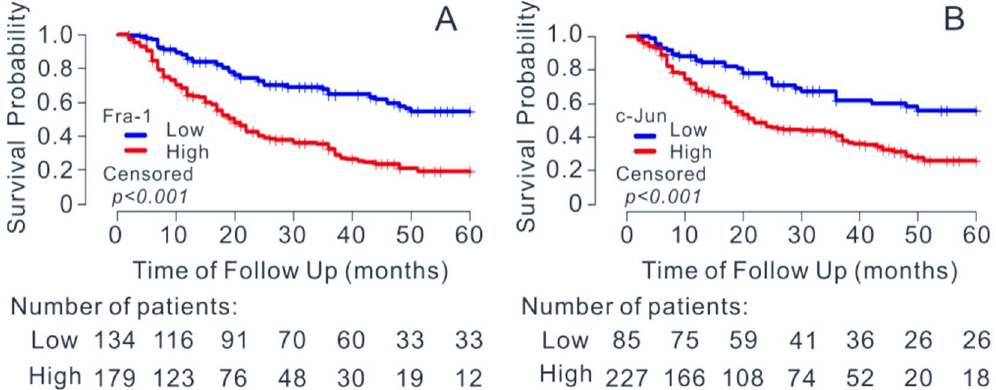
Figure 2. Survival curves of OSCC patients with different expression of c-Jun and Fra-1. ( A ) Correlation between 5-yr survival rate with the expression of Fra-1. ( B ) Correlation between 5-yr survival rate with the expression of c-Jun. The survival curves were defined by the Kaplan–Meier method, the tests of survival rates were performed by log-rank